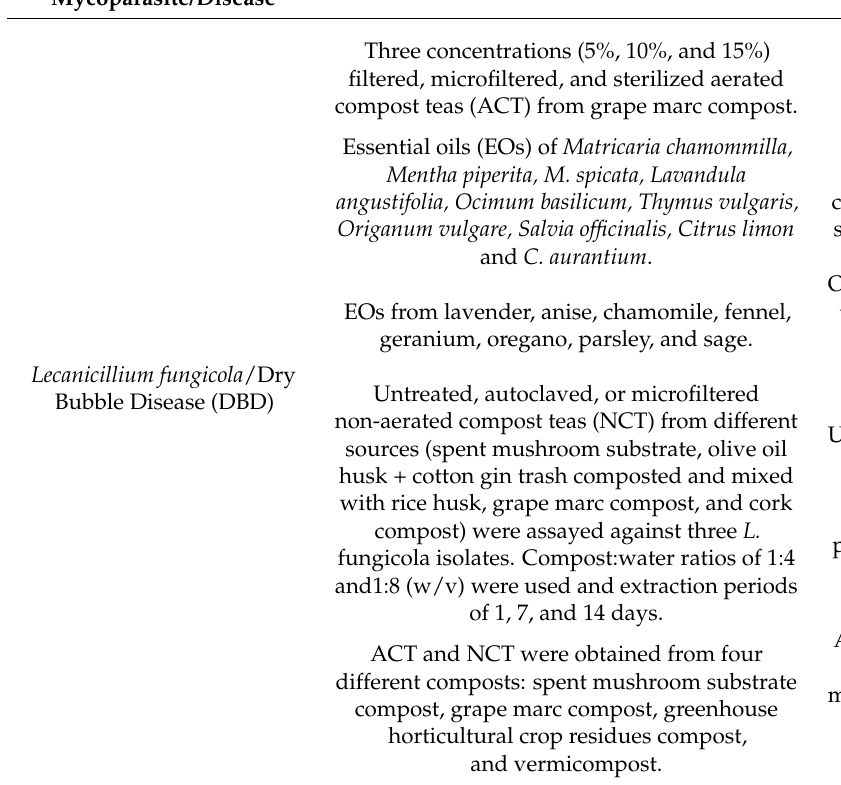
Table 1. Alternative bio-based formulations employed to fight mycoparasites of cultivated mushrooms: EOs from botanicals, plant extracts, and compost teas (last 15 years).